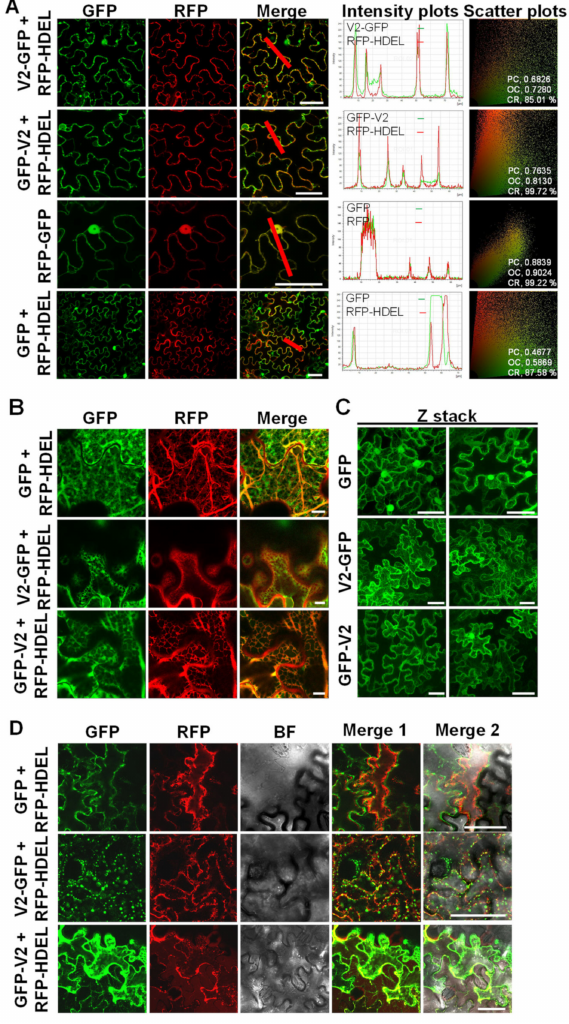
Figure 1. Subcellular localization of GFP-fused V2 proteins in N. benthamiana epidermal cells. ( A ) Colocalization analysis of GFP-fused V2 and the ER marker RFP-HDEL. N. benthamiana leaves were infiltrated with A. tumefaciens carrying constructs to express a fused protein RFP-GFP, as positive control, or co-infiltrated with A. tumefaciens carrying constructs expressing RFP-HDEL and V2-GFP, GFP-V2, or free GFP as a negative control. Protein accumulation was observed under the confocal microscope at two days post infiltration (dpi). Scale bar: 50 µ m. Colocalization between the GFP and RFP channels is analyzed with intensity plots (under the red line of the merge image) and scatter plots. (PC: Pearson’s Correlation, OC: Overlap Coefficient, CR: Co-localization Rate.) ( B ) Close-up of co-expressed free GFP, V2-GFP, or GFP-V2, with RFP-HDEL. Bar: 50 µ m. ( C ) Maximum projection of Z-stack images of free GFP, V2-GFP, and GFP-V2. Scale bar: 50 µ m. Videos for the Z-stack